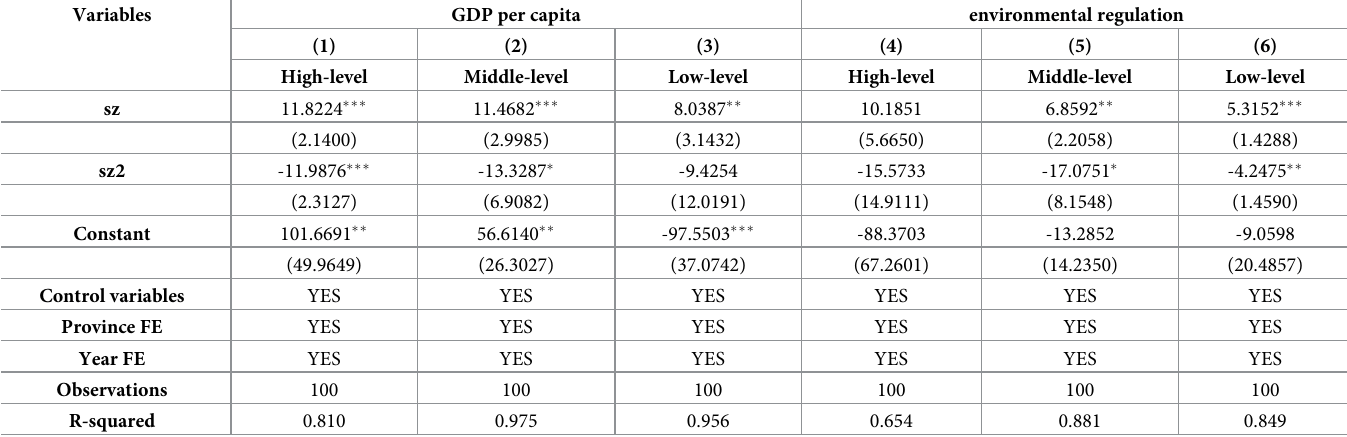
Table 7. Heterogeneity